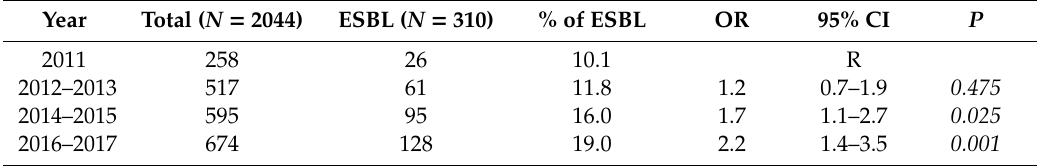
Table 2. The proportion of ESBL-producing uropathogens among children with UTIs caused by Escherichia coli and Klebsiella spp. by diagnosed